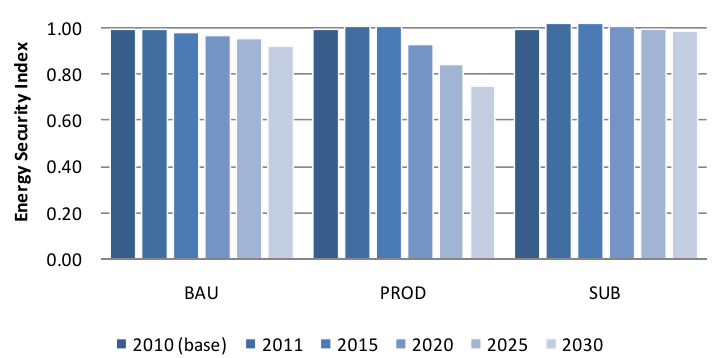
Figure 8. Indonesia’s overall energy security